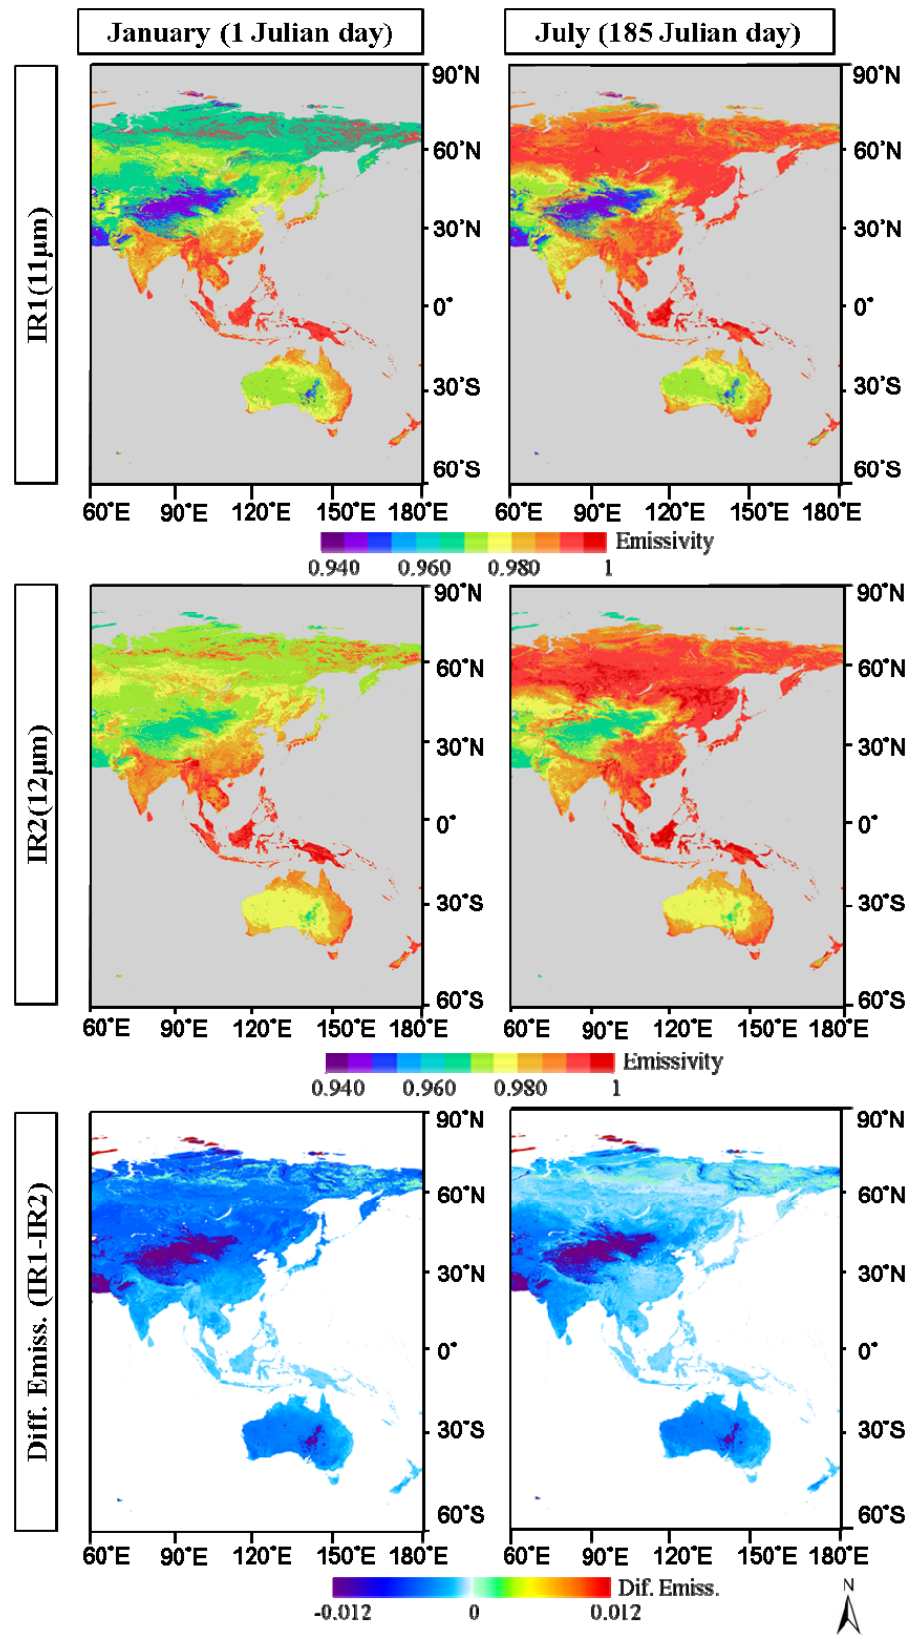
Figure 6. Spatial distribution of surface emissivity and differences in surface emissivity for COMS IR1 and IR2 during the first half of January and July. Values were derived using the vegetation cover method